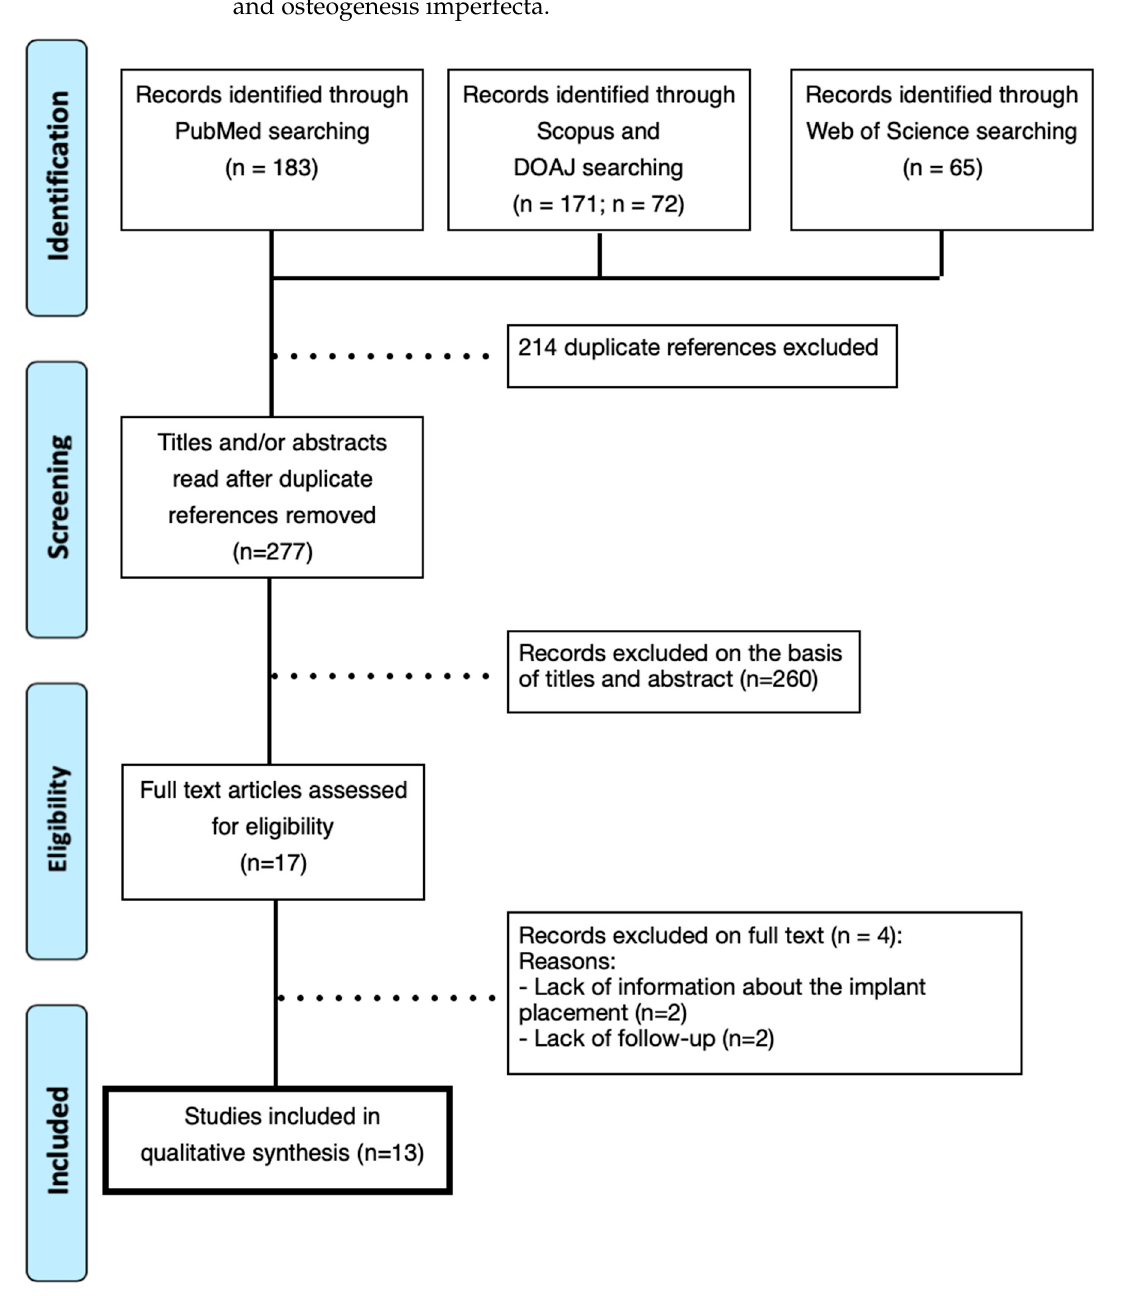
Figure 1. Article selection strategy, according to the PRISMA Flowchart (Preferred Reporting Items for Systematic Reviews and Meta-Analyses).